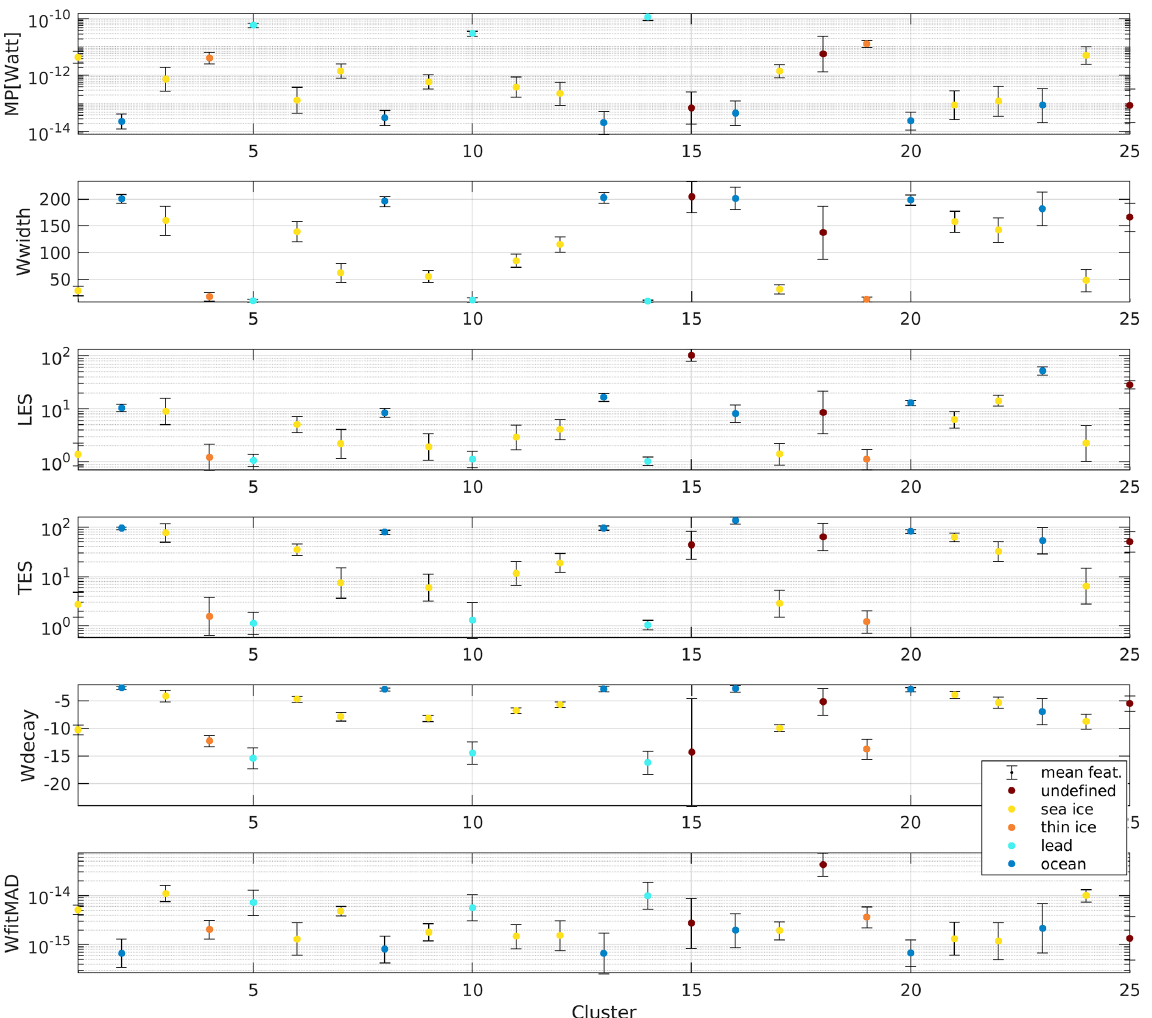
Figure 2. Averages and standard error of six waveform features used per cluster: maximum power (MP), waveform width (Wwidth), leading- edge slope (LES), trailing-edge slope (TES), waveform decay (Wdecay), and median absolute deviation of fitted waveforms (WfitMAD). Colours indicate five different surface types: undefined (brown), sea ice (yellow), thin ice (orange), lead (cyan), and ocean